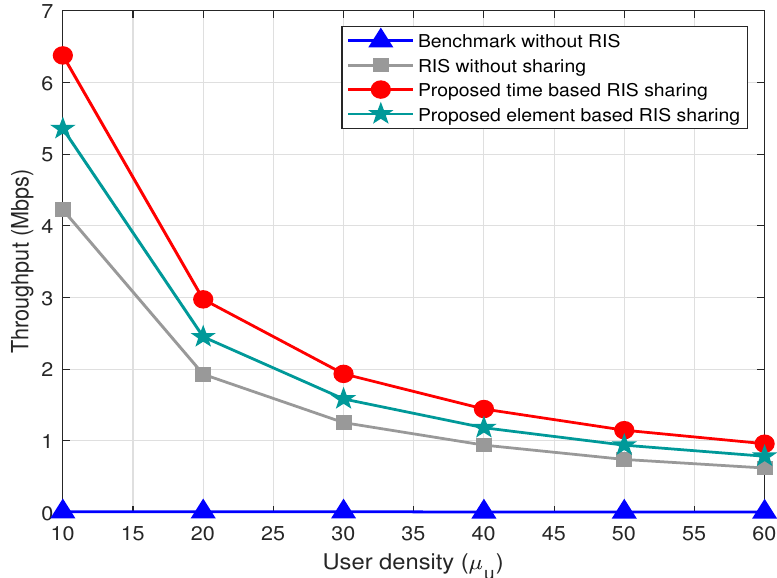
Figure 6. Variation of throughput with respect to µ u for µ pu = 40%, N = 40, µ b = 2, and α = 1.